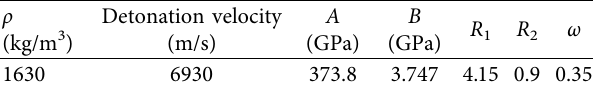
Figure 1: Computational analysis models. (a) Comparative reference model without vibration-isolating slot. (b) Analysis models with various vibration-isolating slot depths. (c) Analysis models with various vibration-isolating slot positions. Table 1: Parameters of the TNTexplosive material model [27,